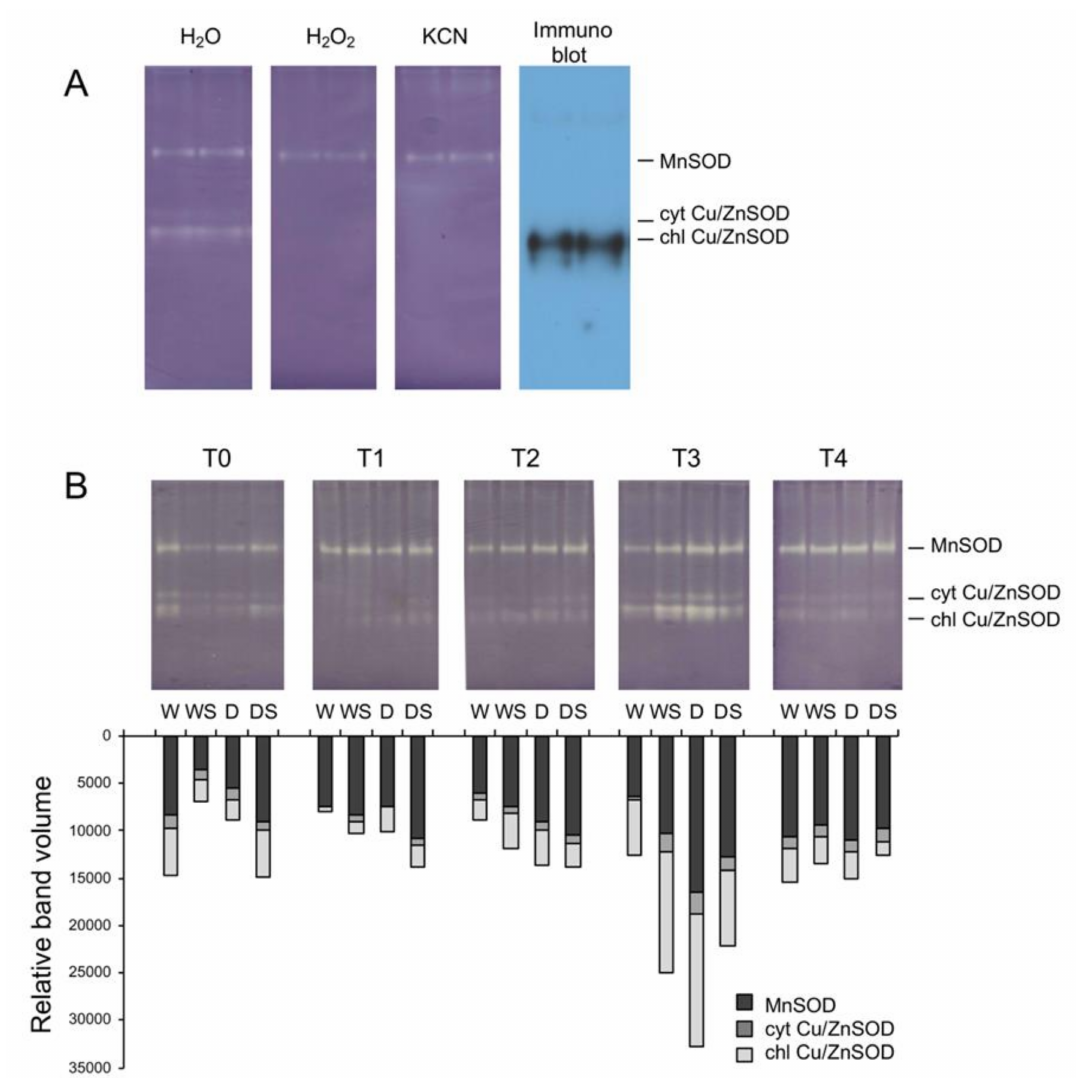
Figure 5. ( A )—Identification of superoxide dismutase (SOD) isoforms after native polyacrylamide gel electrophoresis (PAGE) separation. SOD was assayed in the presence or absence of inhibitors 1M KCN or 5 mM H2O2; the proteins separated by native PAGE were also immunoblotted using anti-chloroplastic Cu / ZnSOD antibodies. ( B )—Zymograms of SOD isoforms. Total soluble proteins isolated from leaves (40 µ g proteins / lane) of watered plants (W), drought-stressed plants (D), watered plants treated with SA (WS) or drought-stressed plants treated with SA (DS) were separated by native PAGE and assayed for SOD activity. T0–T4 are di ff erent sampling points (see Figure 1). Relative band volumes for individual SOD isoforms are represented by stacked